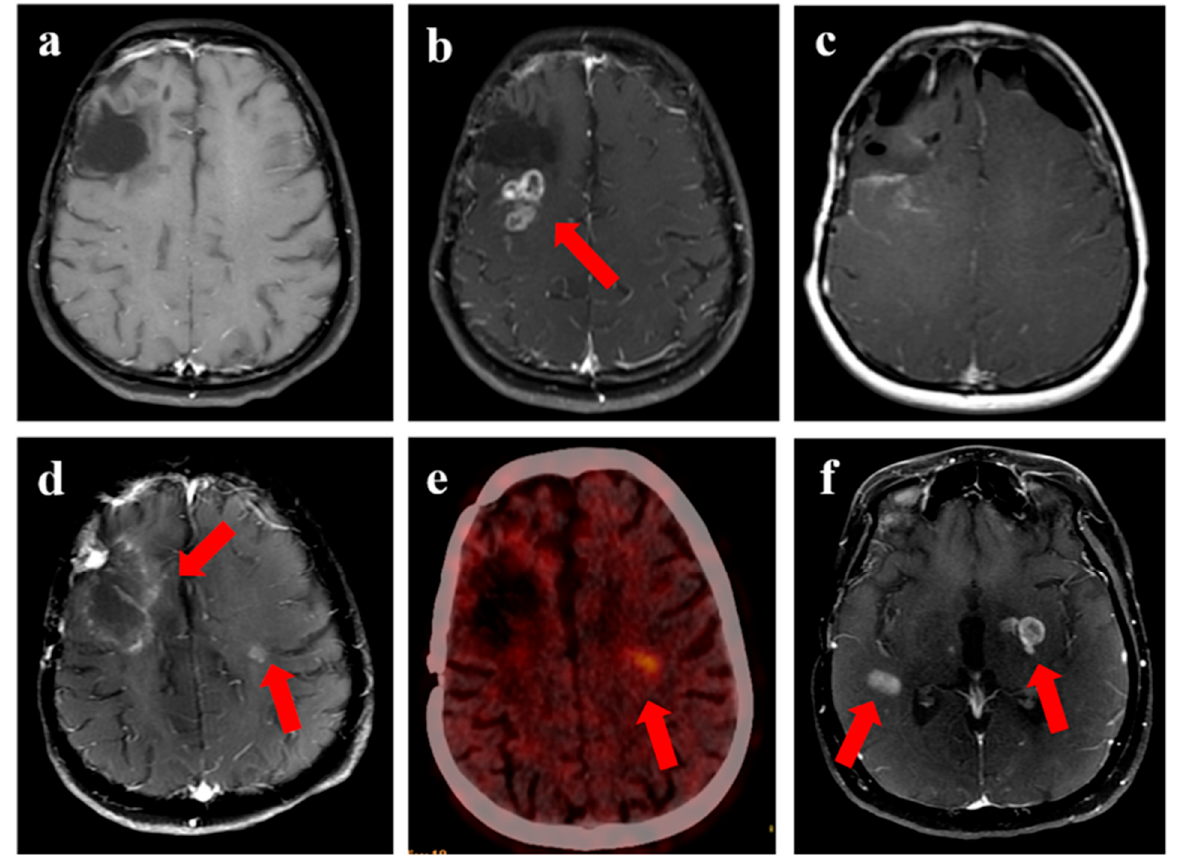
Figure 4. Disease evolution from first progression to subsequent recurrence following re-irradiation in a 25-year female with IDH-mutant grade 3 astrocytoma. ( a ) shows T1w contrast-enhanced MRI with resection cavity over the right frontal region, with contrast-enhancing recurrent disease seen over the posterior aspect of the cavity (arrow) in ( b ). Subsequent imaging shows MRI following resection of the disease in ( c ), which was confirmed as recurrent HGG. ( d ) shows an enhancing area with central necrosis over the resected and re-irradiated region (8 months following ReRT) over the right frontal-parietal, which was not showing any metabolic uptake on corresponding PET imaging in ( e ). However, the other area of enhancing nodule over the left periventricular region shows high avidity, considered a distant recurrence. ( f ) shows MRI performed after 2 months, which confirmed new areas of distant disease, while the re-irradiated region (non-avid on PET) continued to be stable, con fi rming RT-related changes.